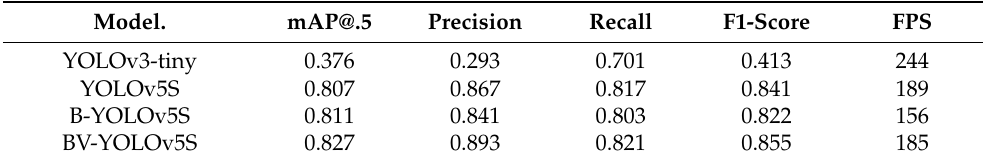
Table 2. Evaluation Results of Four Types of Models.